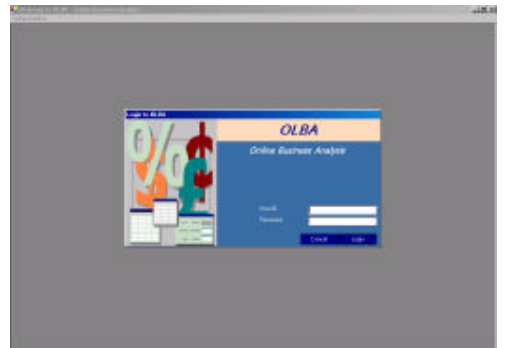
Figure 4: OLBA – User Interface